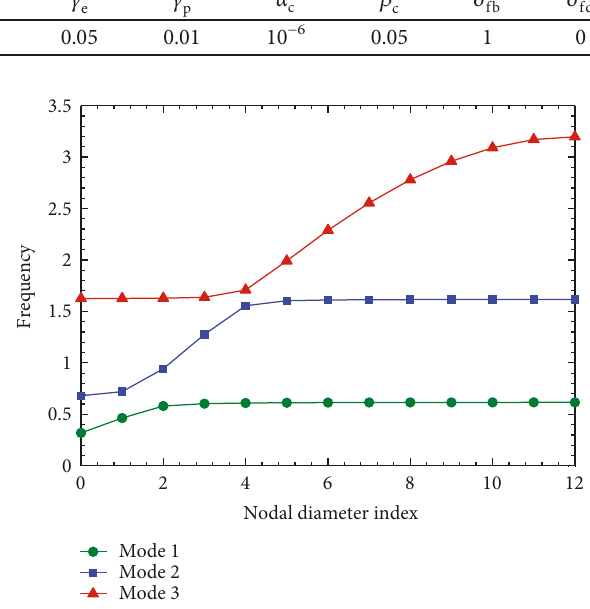
Figure 5: Frequency/nodal diameter index (NDI) map of the